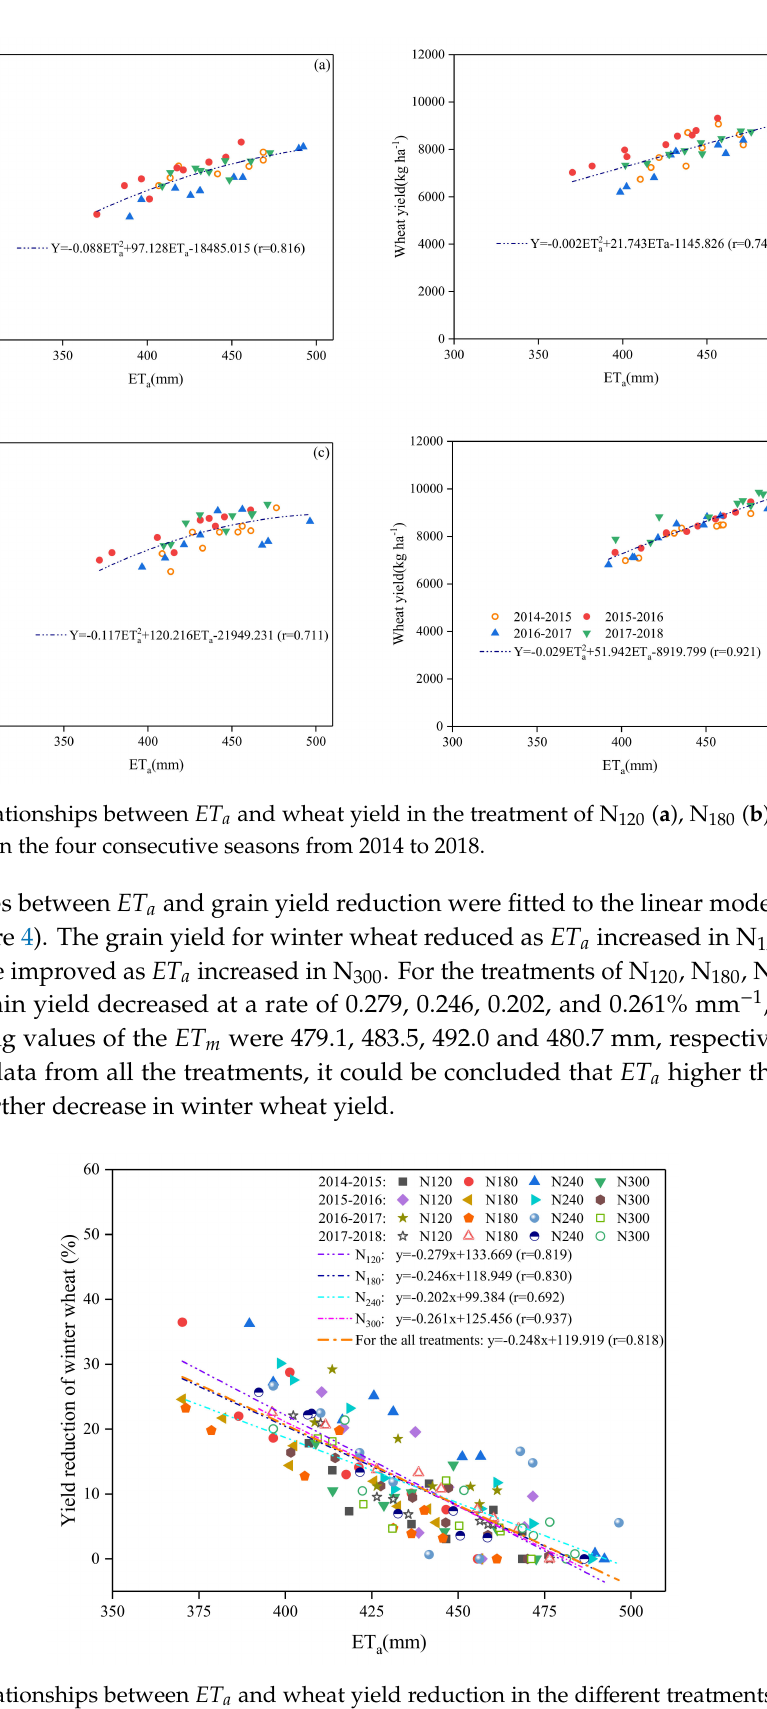
Figure 4. Relationships between ET a and wheat yield reduction in the di ff erent treatments over the four consecutive wheat seasons from 2014 to